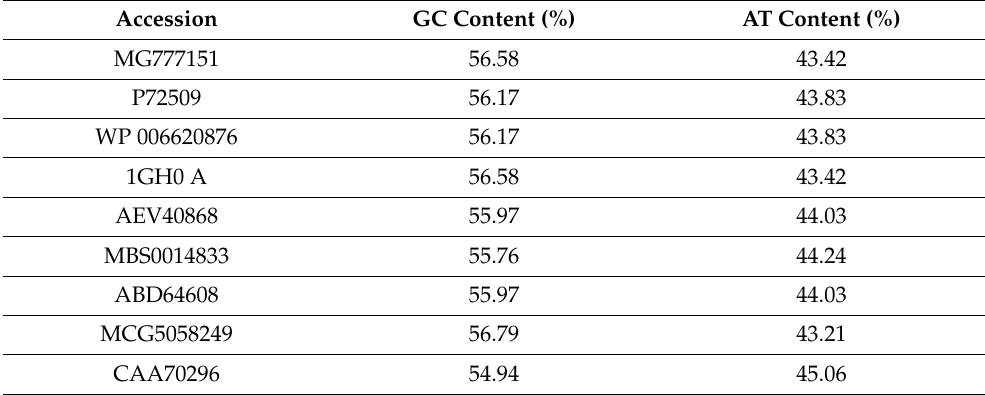
Table 4. The GC and AT content of the analyzed nucleotide sequences of nine cyanobacterial spe- cies, including A. platensis strains and variants.